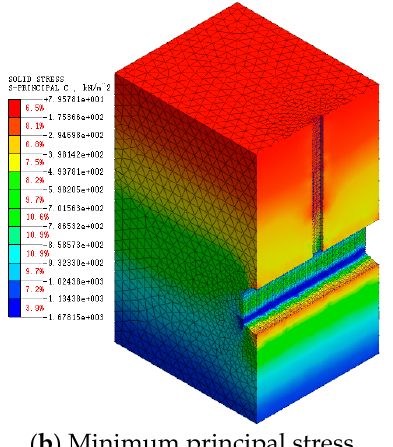
Figure 15. Principal stress of surrounding rock.